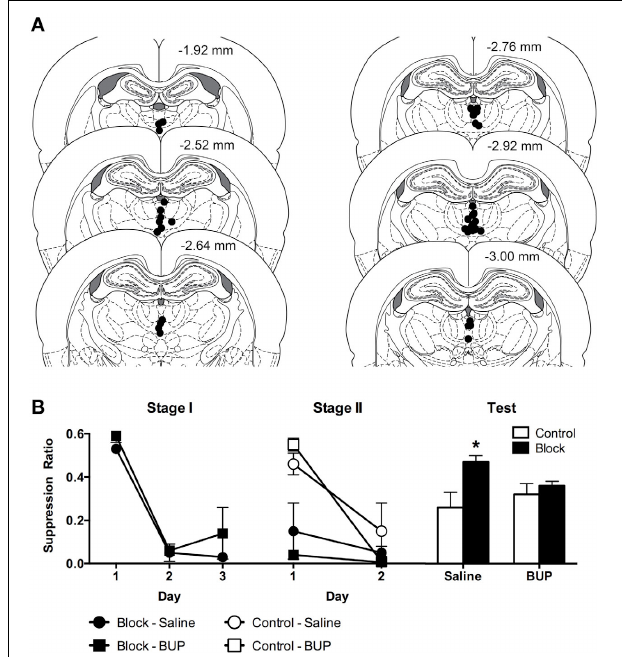
FIGURE 1 | (A) Cannula placements in the midline thalamus according to the atlas of Paxinos and Watson (2007). Each circle represents the ventral tip of the microinjection cannulae. (B) Mean and SEM suppression ratios across Stage I, Stage II, and Test. *Indicates significant difference ( p < 0 . 05) compared to Control-Saline.